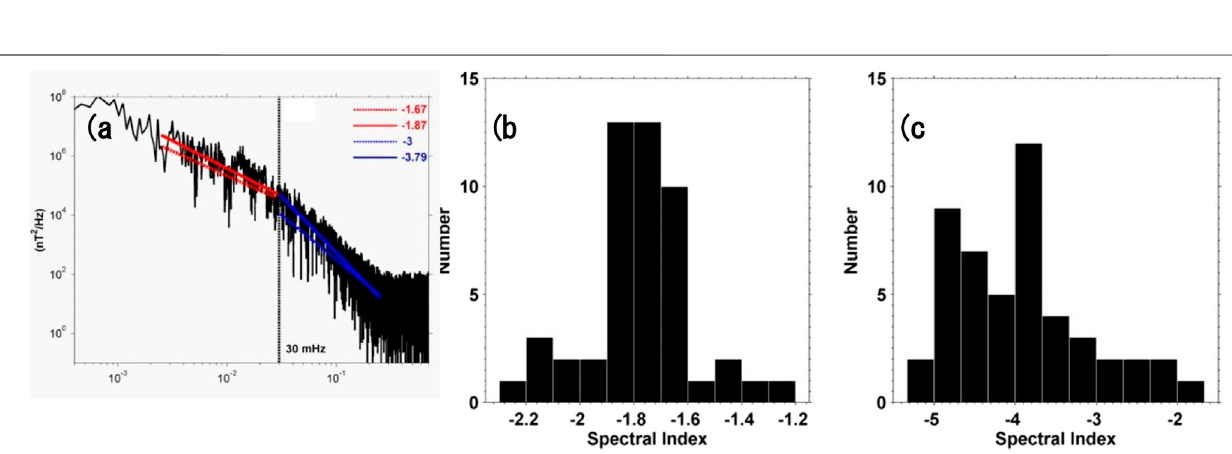
FIGURE 4 | (A) Power spectra for B Z at x (cid:1) − 15 R E , y (cid:1) − 5 R E and z (cid:1) 0 for southward IMF. Histograms of (B) inertial range PSD slopes (C) Dissipative range PSD slopes for southward IMF. (After El-Alaoui et al.,